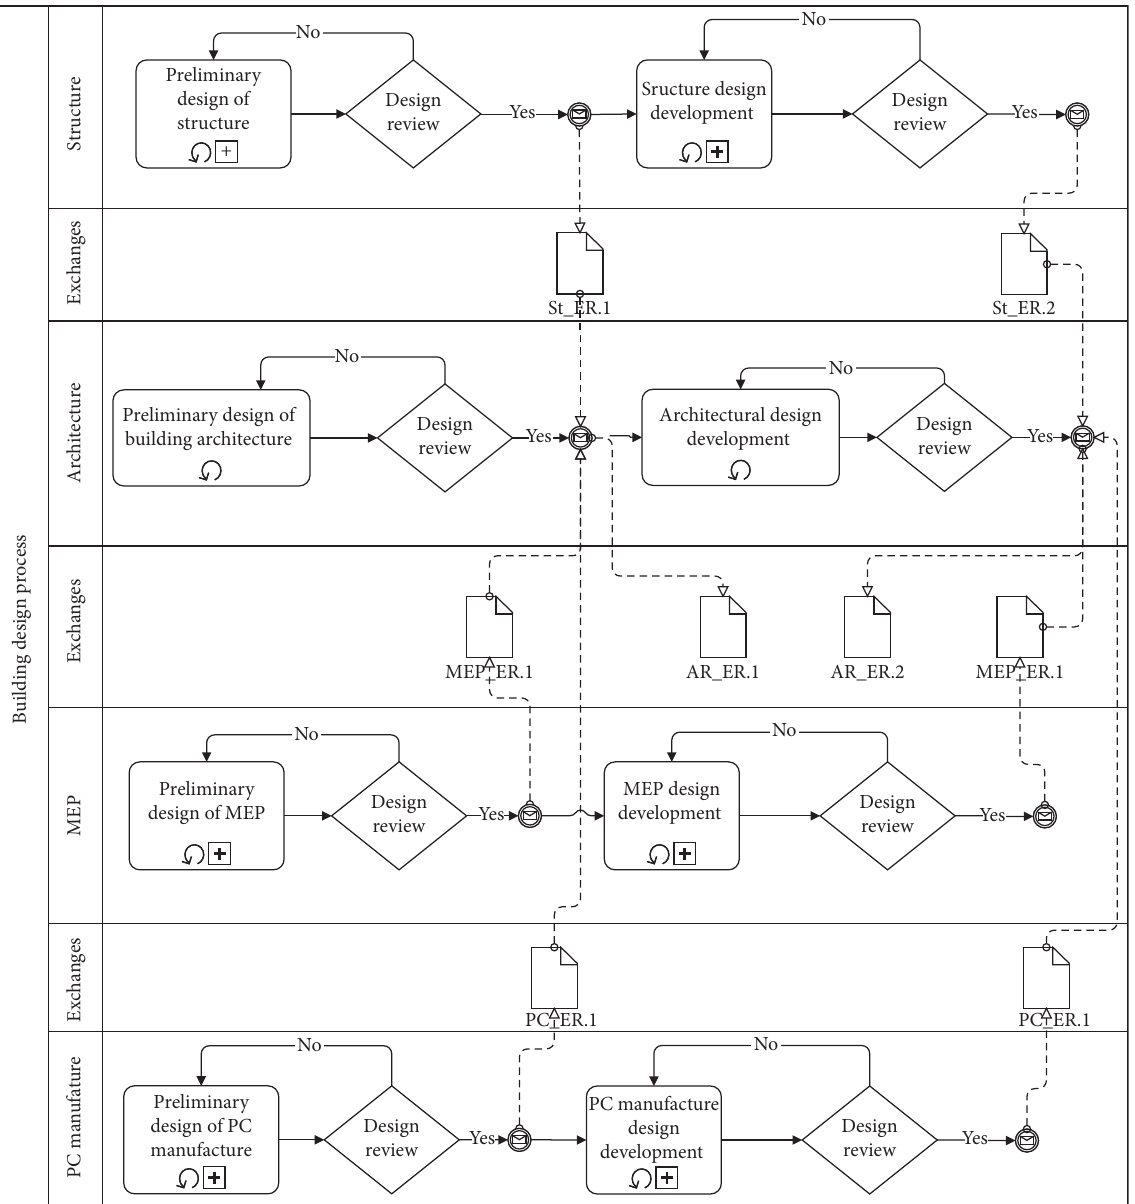
Figure 8: Design process map of prefabricated construction.